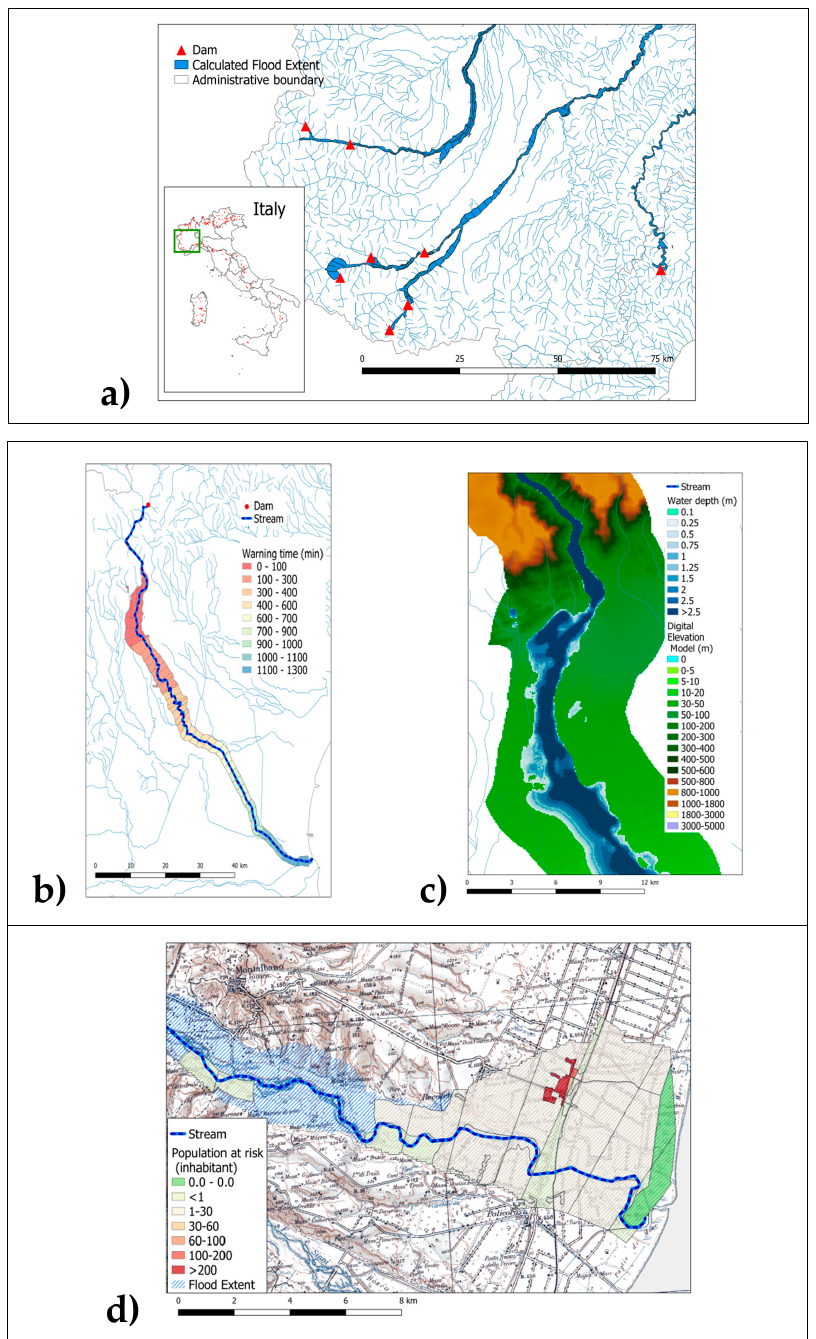
Figure 13. GIS tool example application of instantaneous dam-break due to structural failure for the 250 existing Italian mansory arch and gravity dams: ( a ) an example of the flooded areas calculated for the potential failure of 250 dams; ( b ) an example of the water depth map for a dam area in Northern Italy; ( c ) an example of the wave arrival time map of a dam in Northern Italy; and, ( d ) an example of a loss of life map for an area of a dam in Southern Italy.